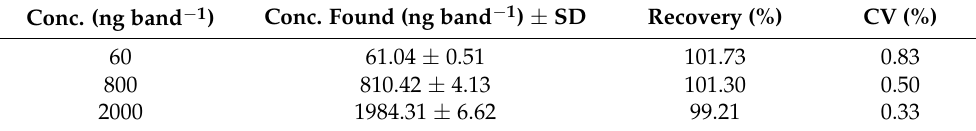
Table 3. Evaluation of accuracy of HSP for a sustainable RP-HPTLC method (mean ± SD; n = 6). Conc. (ng band − 1